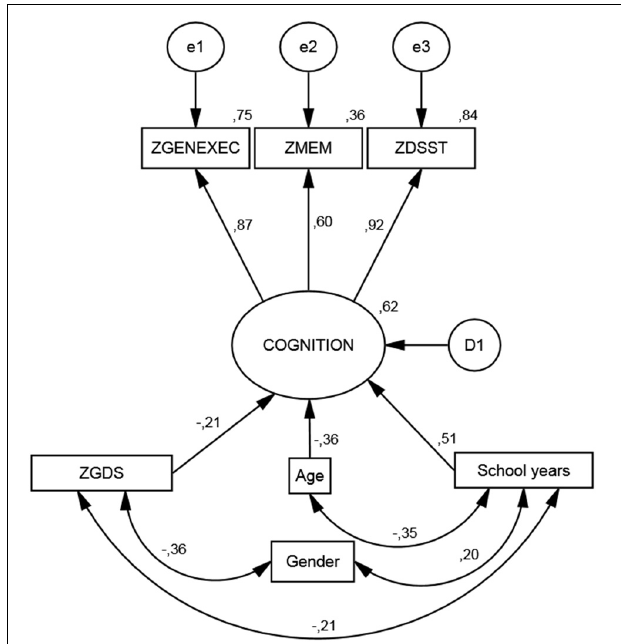
FIGURE 1 | Structural equation model. Standardized coefficients for the cognition measurement model and its predictors.